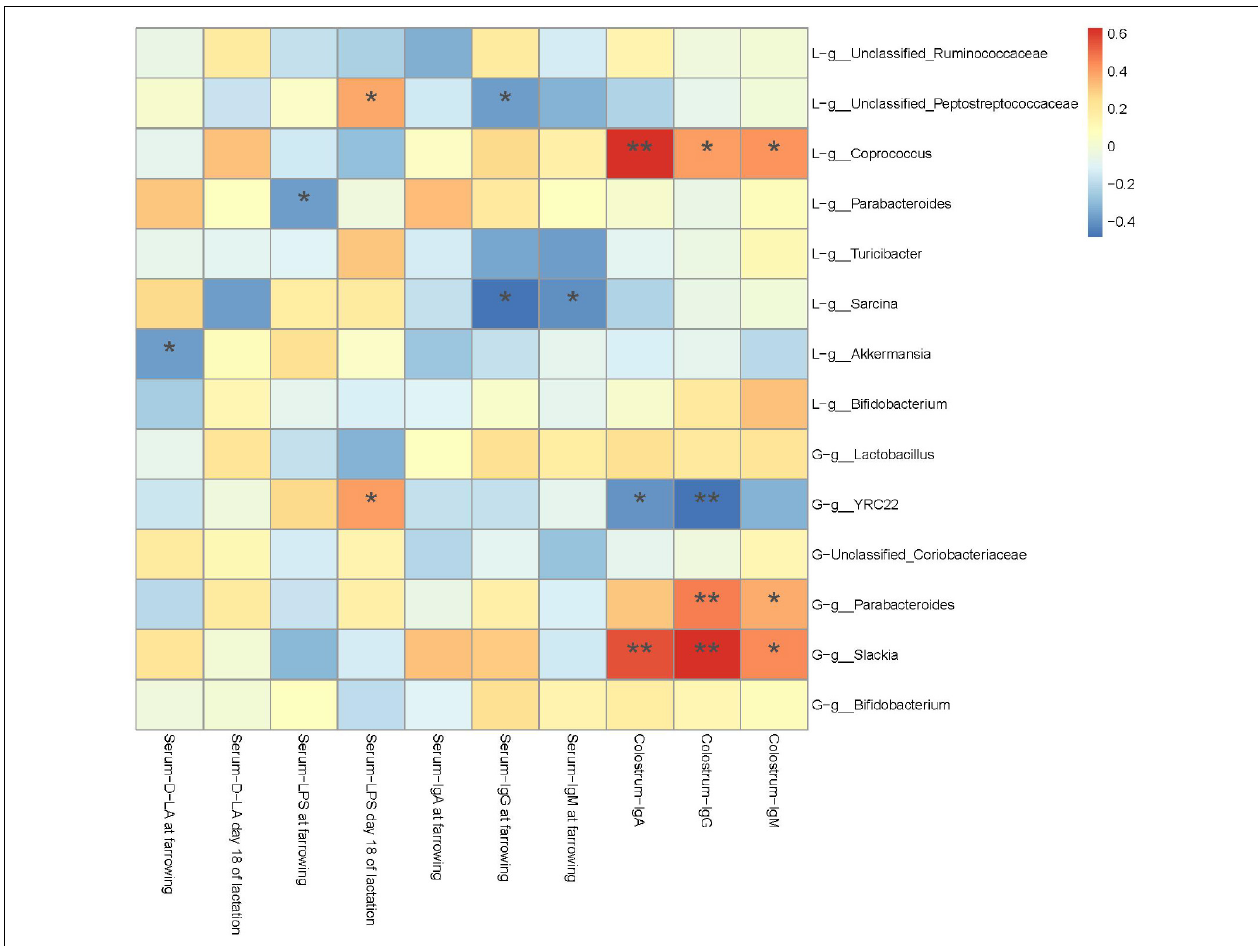
FIGURE 8 | Heatmap of the Spearman’s r correlations between the gut microbiota significantly modified by different dietary treatments and period of sows. Data are presented as means ± SEM ( n = 5 or 7). * P < 0.05; ** P < 0.01 (following the Spearman’s correlation analysis). G, at day 107 of gestation; L, at day 10 of